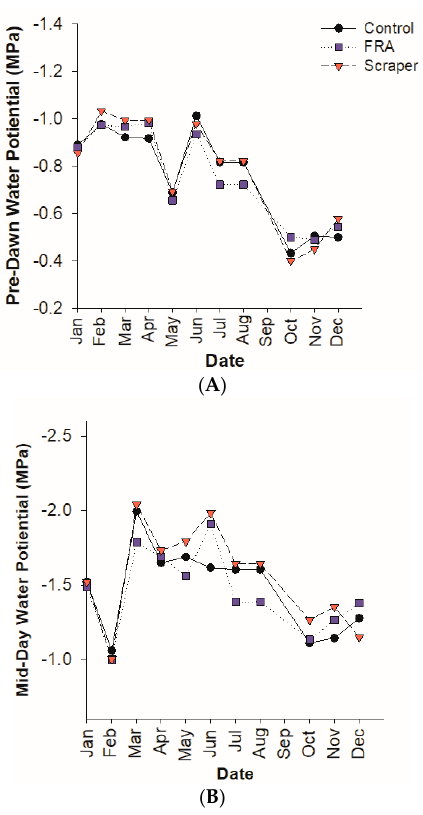
Figure 6. Pre-dawn ( A ) and mid-day ( B ) plant moisture stress measurements taken with a PMS Chamber presented by date, treatment and time of sampling.